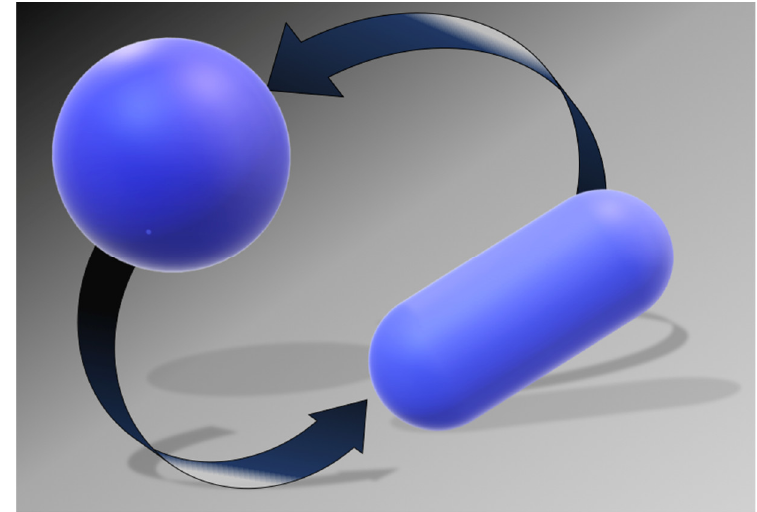
Figure 4. Simple geometric models for the two states of a globular protein: the sphere for the N-state and the prolate spherocylinder for the D-state.